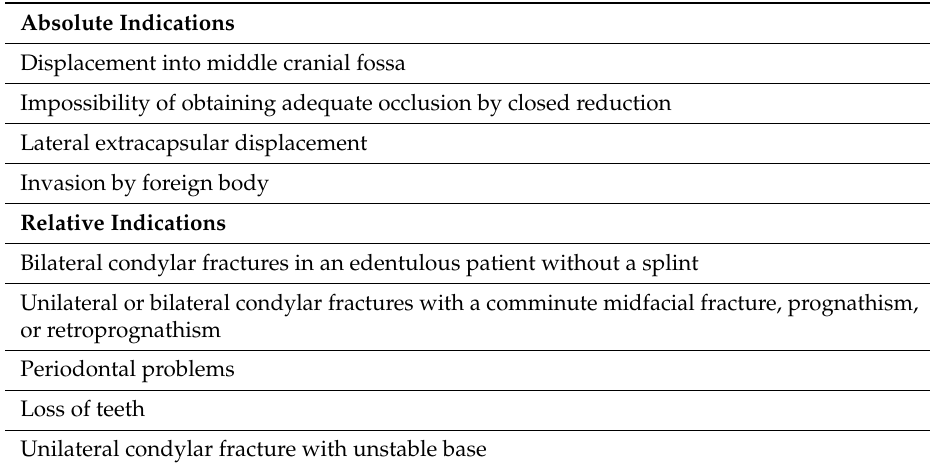
Table 1. Zide and Kent’s indications for open reduction (1983) [1,2].